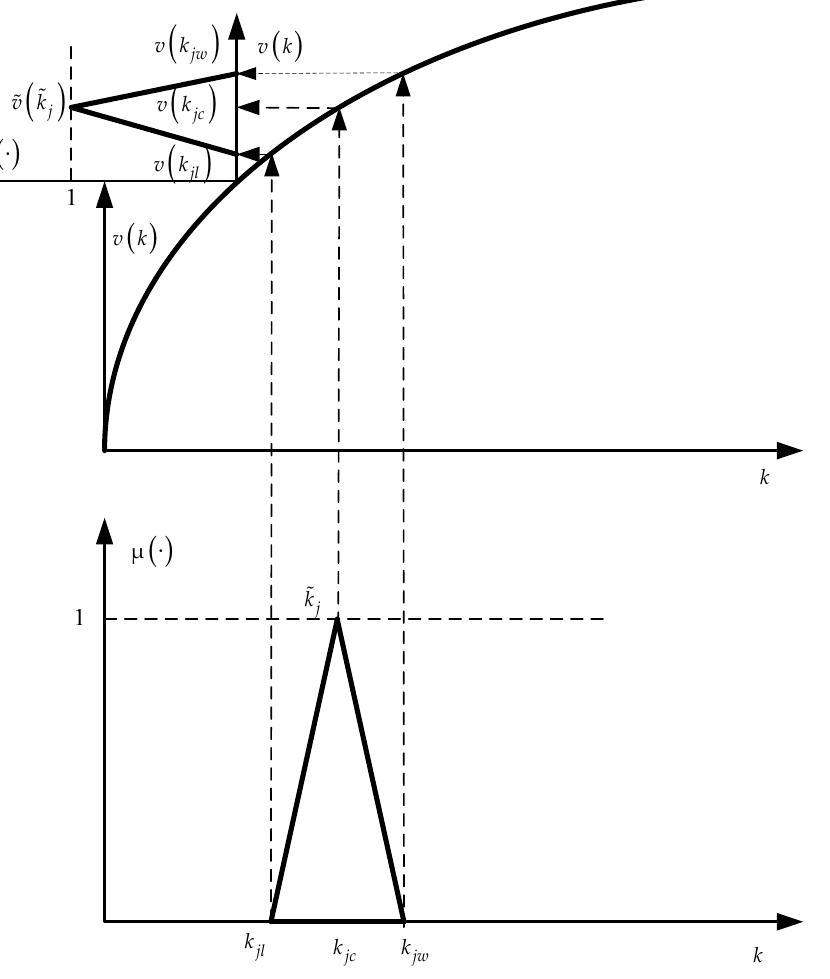
Figure 6. The transformation of a fuzzy outcome’s estimate into a fuzzy value’s estimate. Using the given fuzzy number (cid:101) k j and the graph of the function v ( k ) , we define the characteristic points v